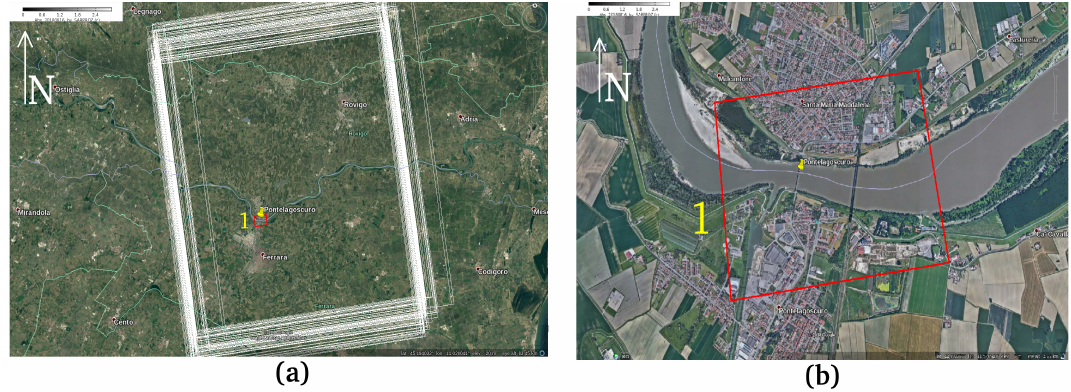
Figure 5. Case study 1 optical representations. ( a ): georeferenced footprints of the SAR long temporal series. ( b ): region of interest (ROI) footprint.